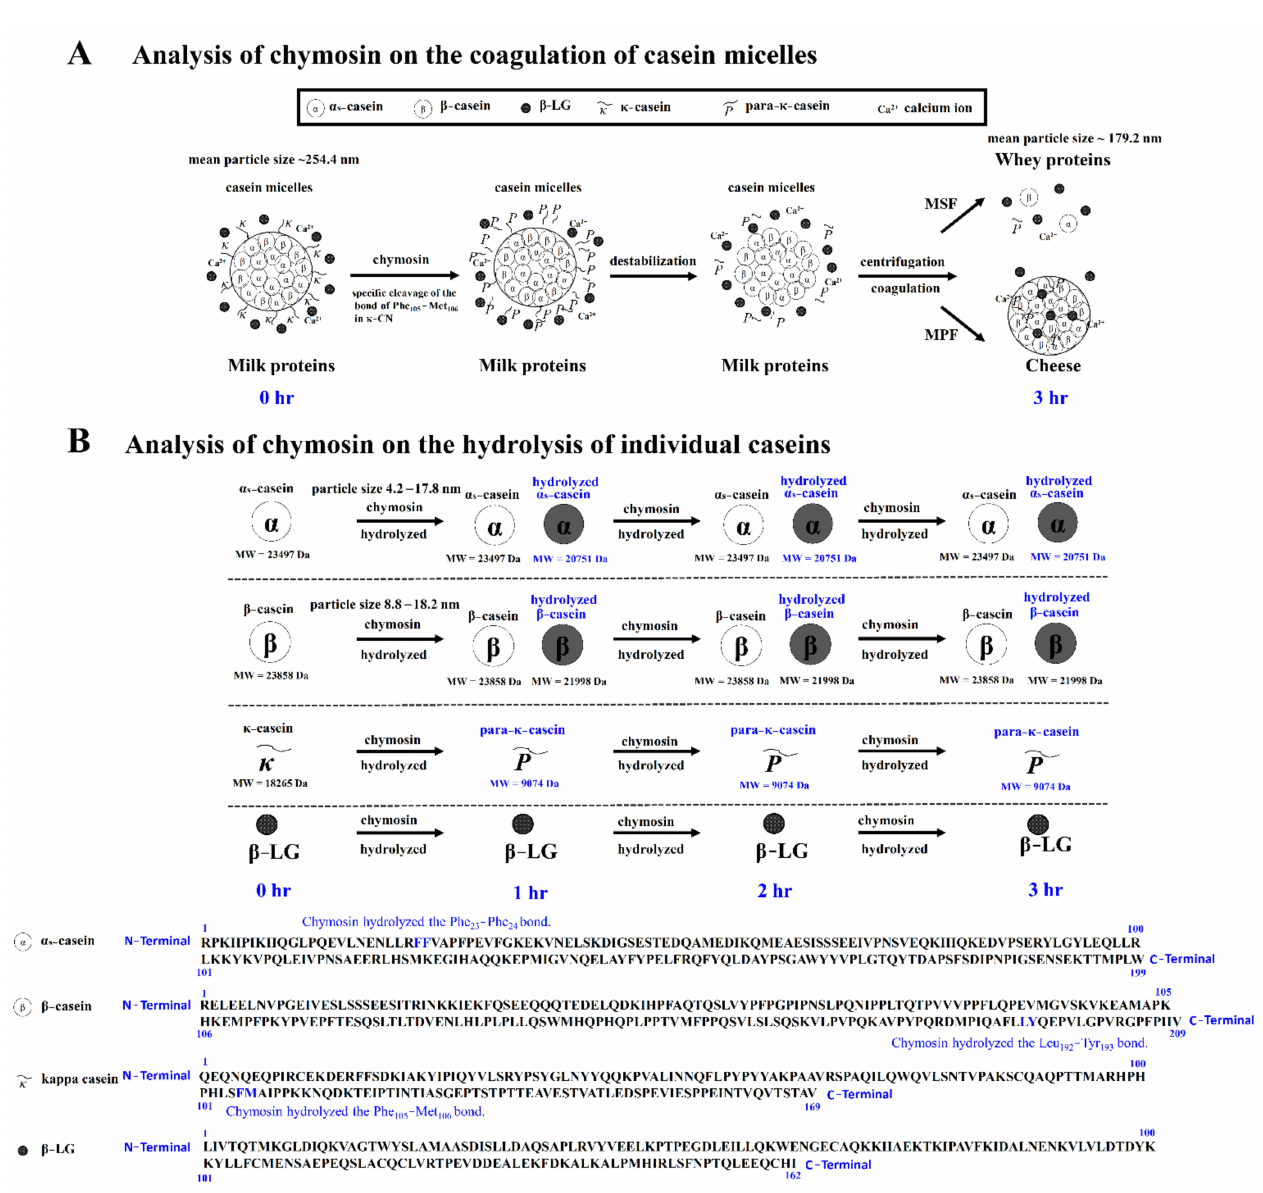
Figure 6. Hydrolysis reaction scheme on the casein micelles and individual caseins induced by chymosin. ( A ) casein micelles; ( B ) individual